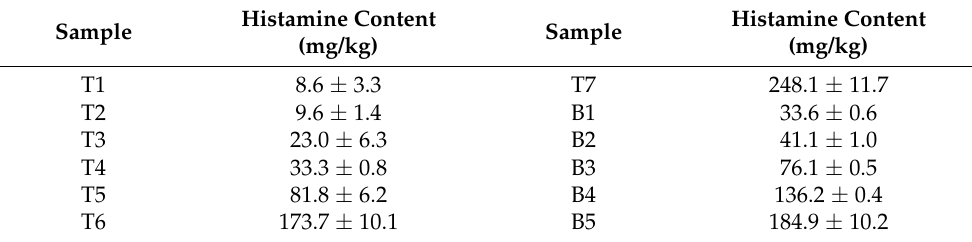
Table 1. Histamine content of samples with naturally formed histamine determined by the reference